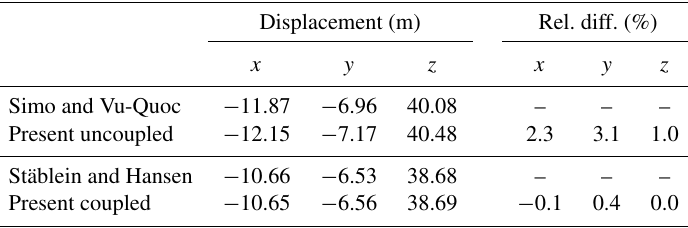
Table 3. Comparison of 45 ◦ bend cantilever tip displacements. Original test case (uncoupled) and modified test case with bend–twist coupling.